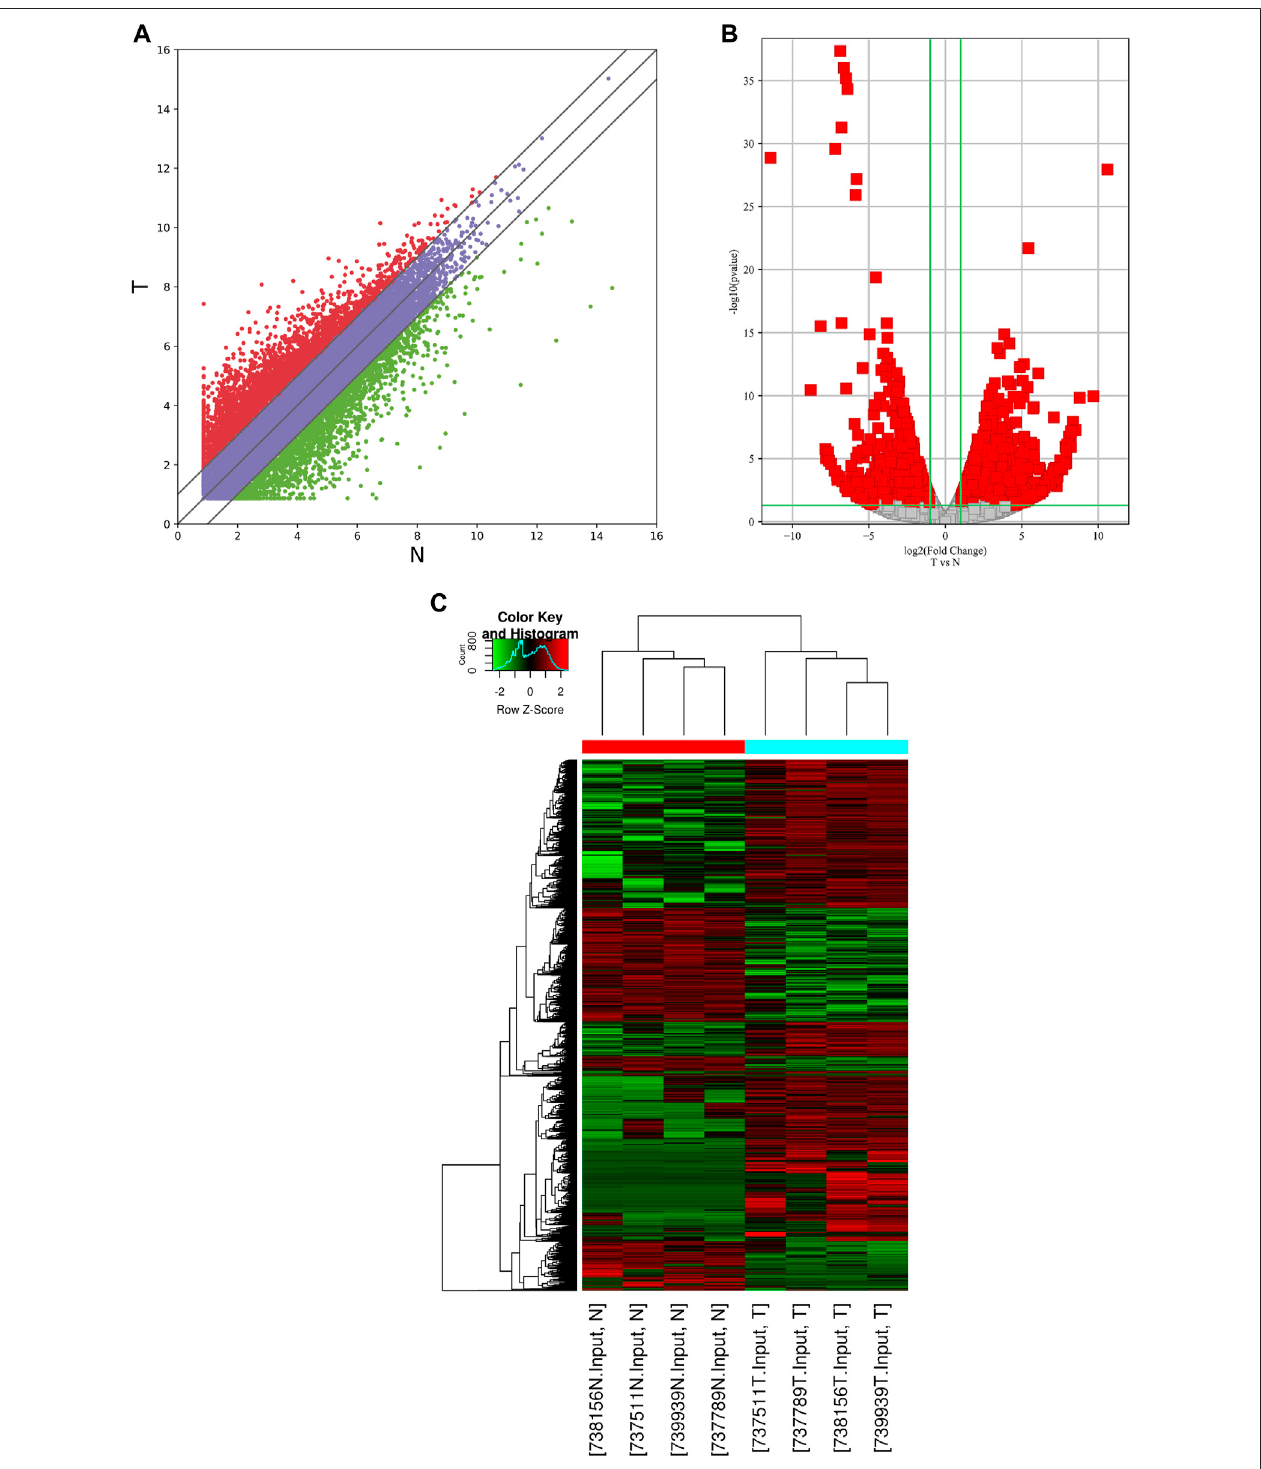
FIGURE3 | Identi fi cation of differentially expressed genesin AEG byRNA-seq. (A) the scatter plotof the RNA-seq data. (B) Volcano Plot ofthe RNA-seq data. (C) Heat map of RNA-seq data of Ca samples and adjacent normal tissues. Red and Green indicate the upregulation and downregulation of mRNAs, respectively.